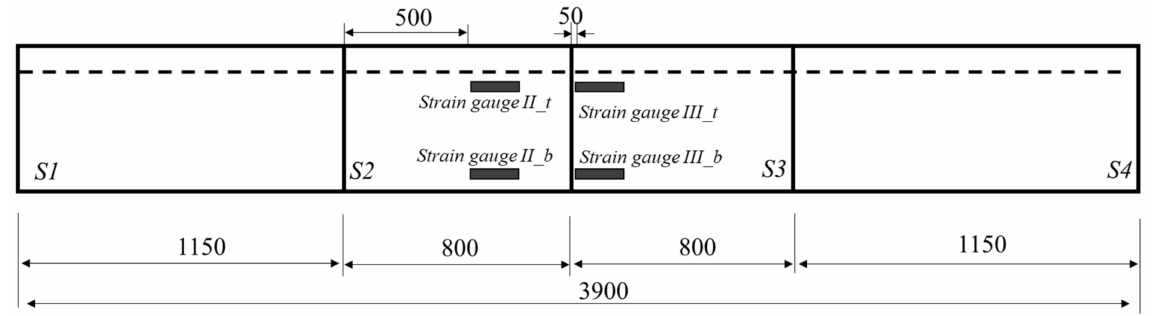
Figure 6. Locations of the strain gauges attached on the segmental